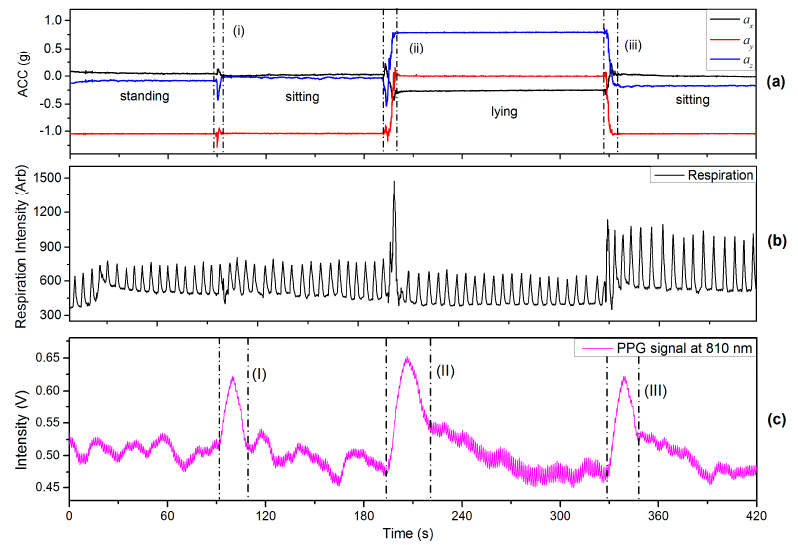
Figure 10. ( a ) ACC; ( b ) respiration and ( c ) PPG signals recorded from changing body positions.